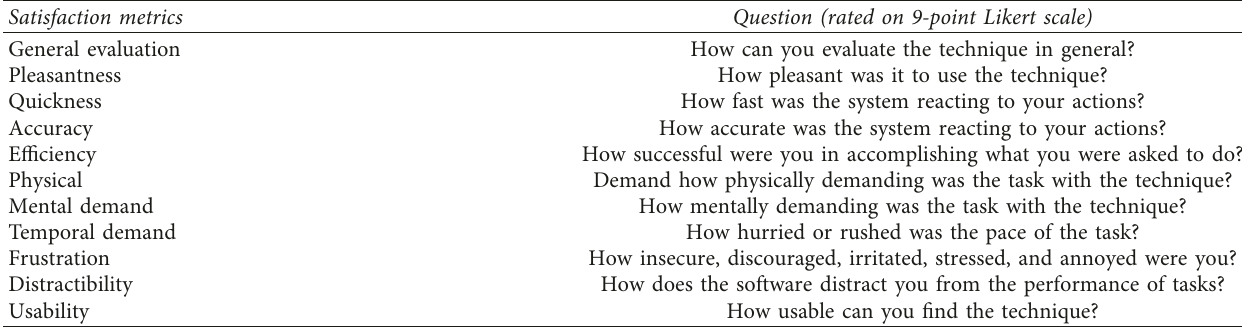
Table 2: User satisfaction evaluation metrics and corresponding